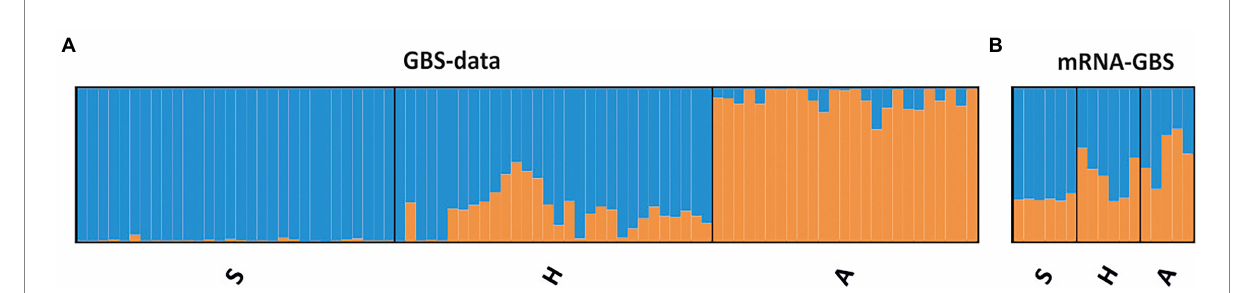
FIGURE 4 Population genetic structure of the investigated red clover individuals (GBS) or site specific bulk samples (mRNA-GBS) across the different Biodiversity Exploratories (S, Schorfheide-Chorin; H, Hainich-Dün; A, Swabian Alb) as revealed by the STRUCTURE analyses and Δ K (Evanno et